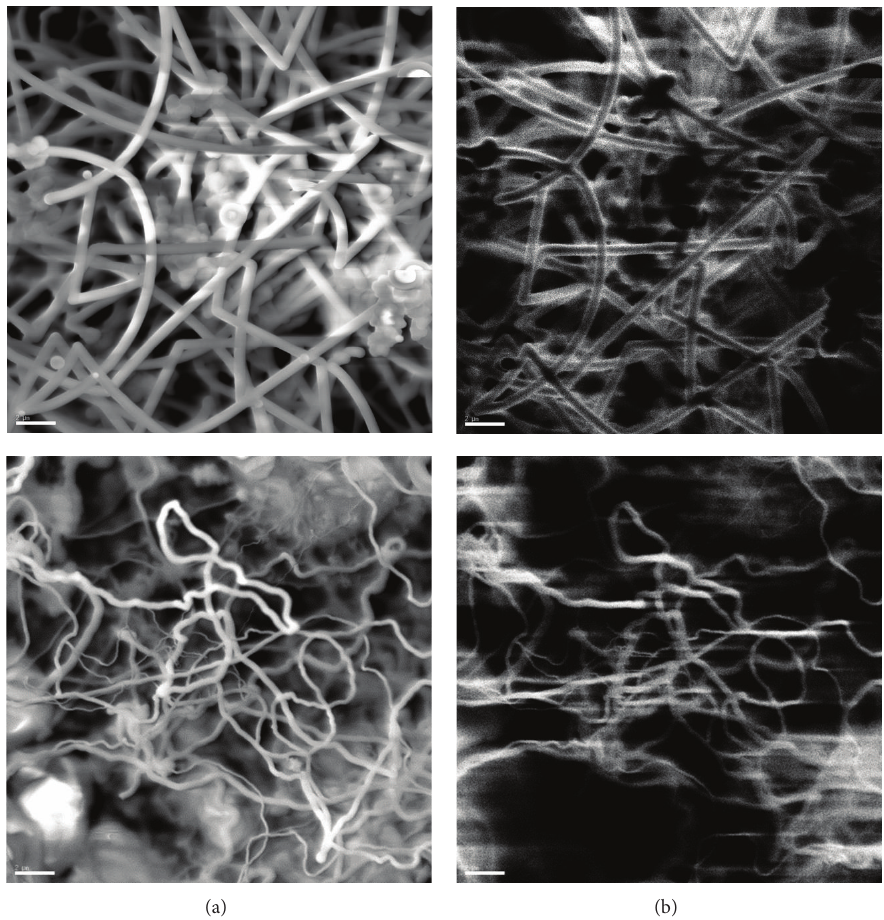
Figure 6: CL data of GaN:Mn nanowires (a) SEM image and (b) CL